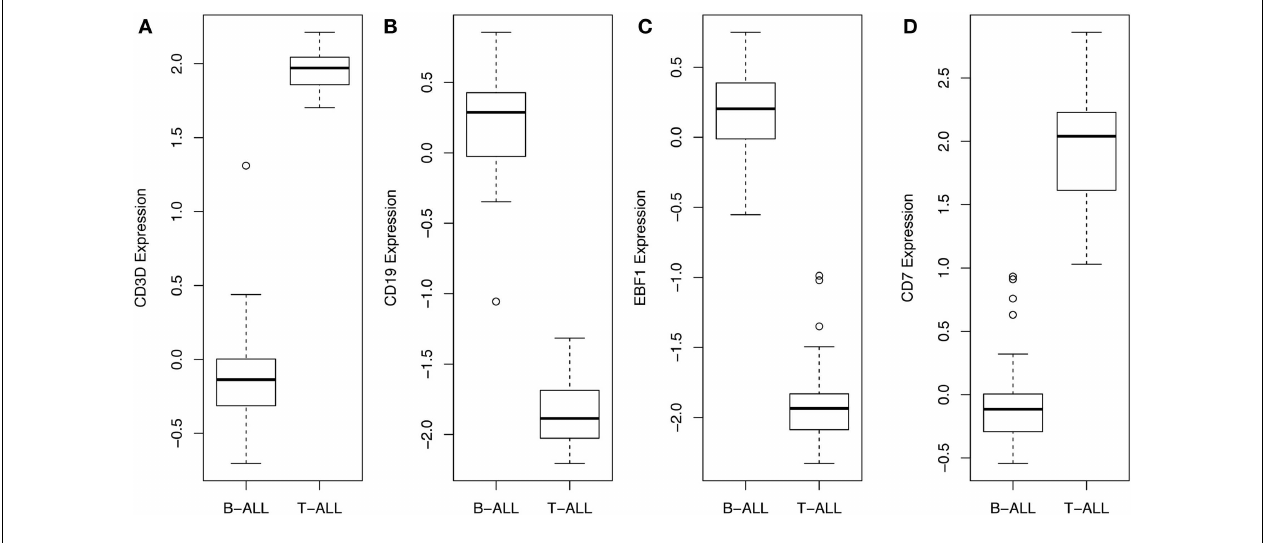
CD7 forT-ALL and CD19 and EBF1 for BCP-ALL (B-ALL) can be used to readily distinguish and verify the original pathological classification of these disease